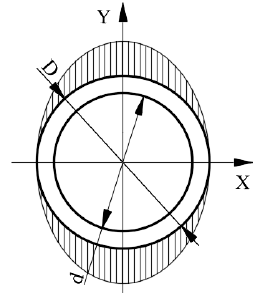
Figure 13. The distribution of shear stress values of the points in the outside surface of the circular ring.